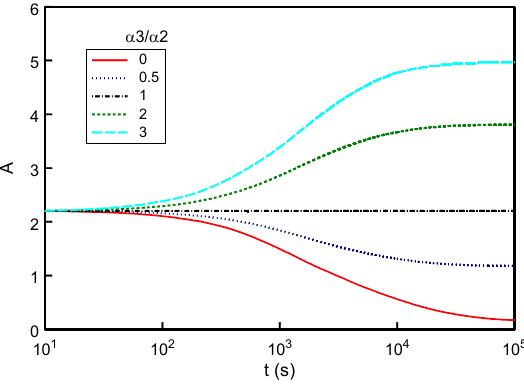
Figure 5. CA simulated dynamical dependence of the optical absorbance for various α 3/ α 2 ratios.